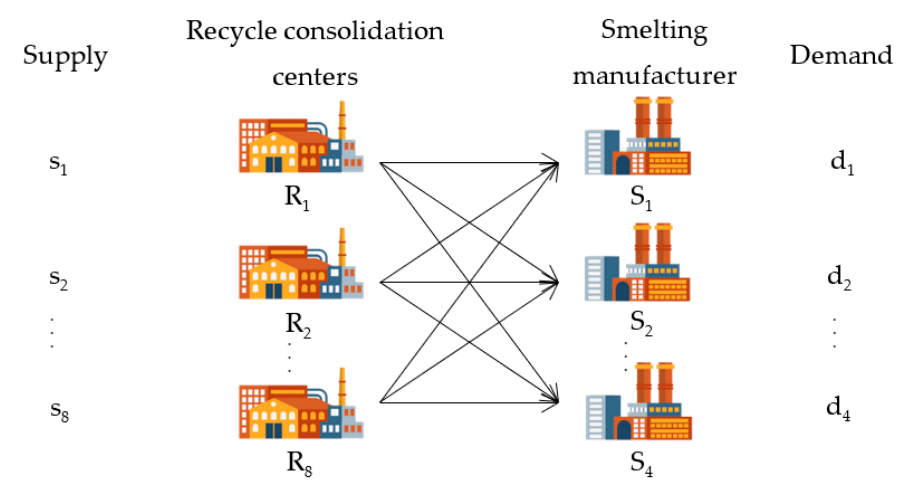
Figure 1. Transportation